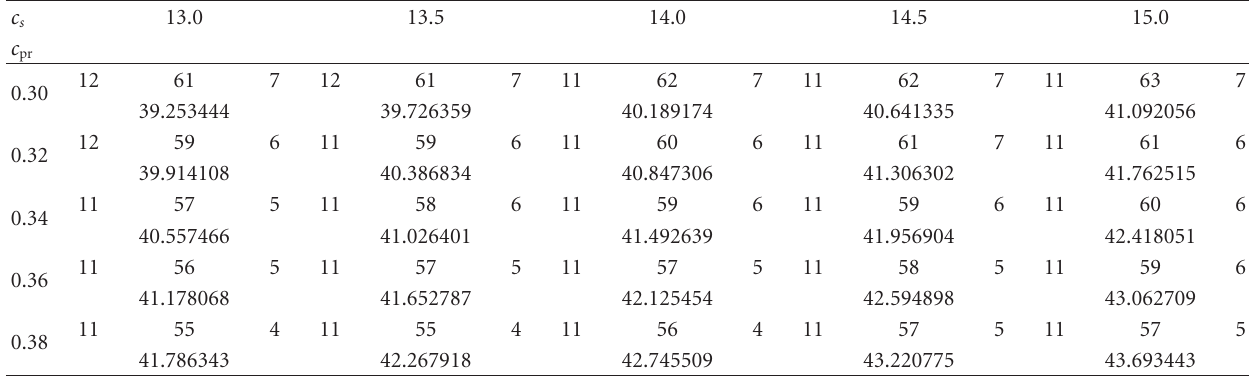
Table 16: E ff ect of c s and c pr on the optimal cost rate ( c h = 0 . 3, c sh = 5, c p = 3).